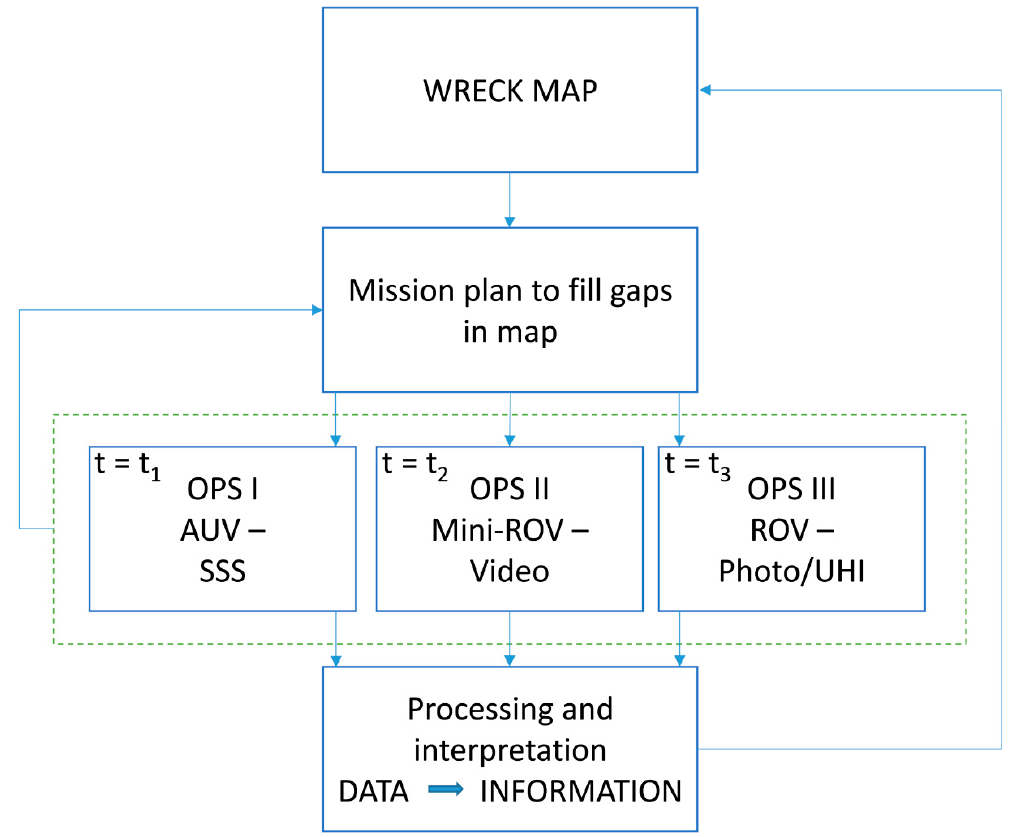
Figure 13. Model of wreck mapping survey showing sequence and data dependency of operations (OPS). AUV = autonomous underwater vehicle, ROV = remotely operated vehicle, SSS = sidescan sonar, t = time, UHI = underwater hyperspectral imaging.